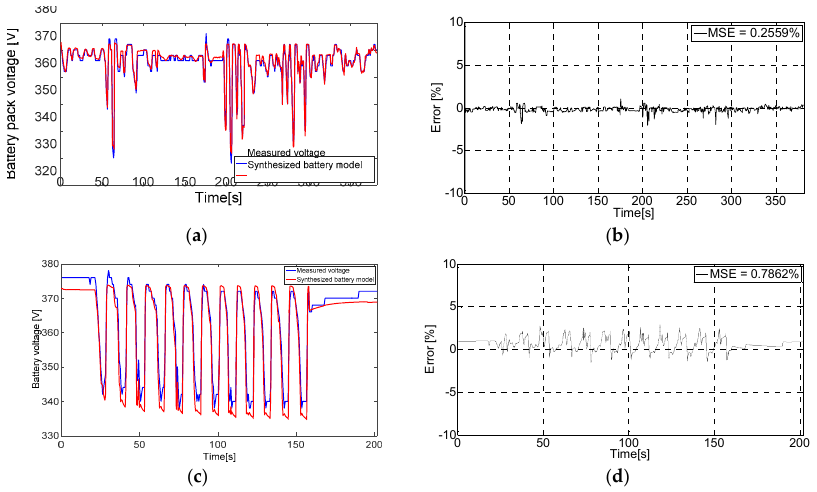
Figure 12. The proposed synthesized battery model and reference voltage signal: ( a ) Proposed model response for the circular driving test; ( b ) Error of proposed model voltage for the circular driving test; ( c ) Proposed model response for the rapid acceleration and deceleration driving test; ( d ) Error of proposed model voltage for the rapid acceleration and deceleration driving